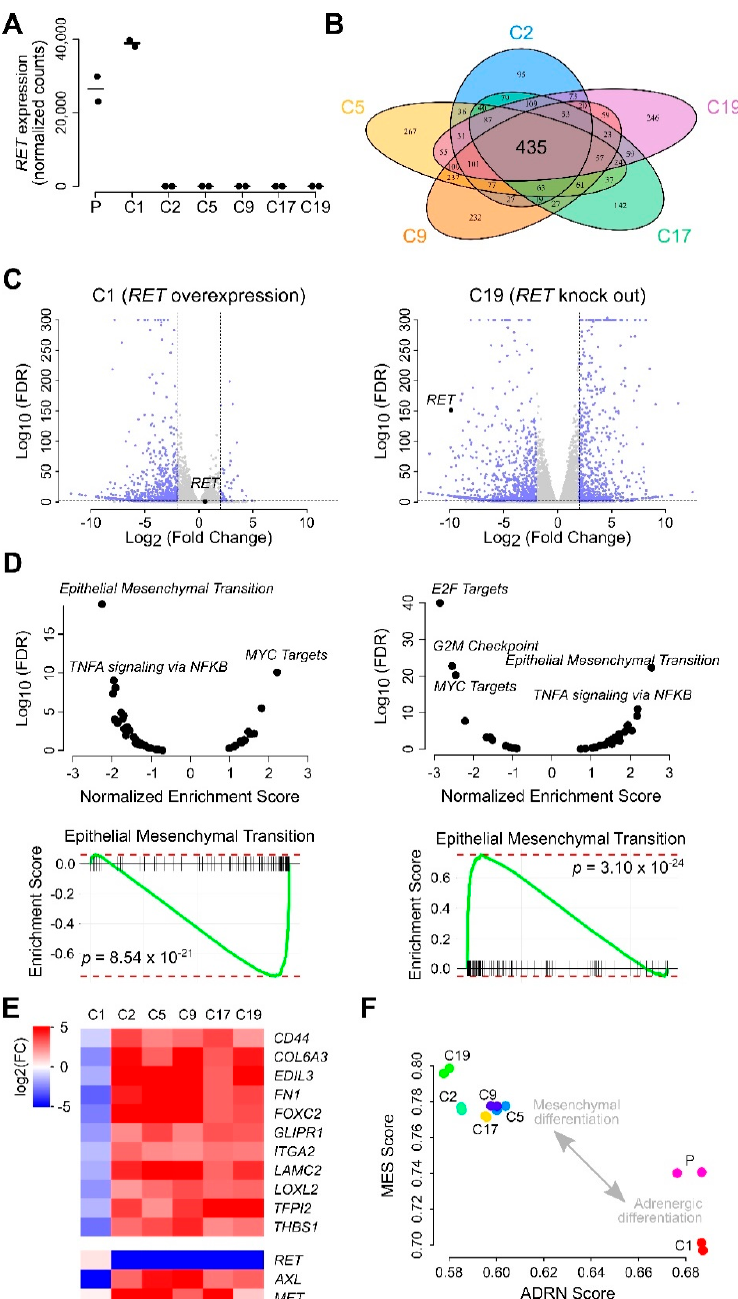
Figure 5. RNA-Seq differential gene expression analysis of RET KO NB cell lines. ( A ) Confirmation of RET KO in different clones. Horizontal lines indicate median values. P stands for parental cells. ( B ) Venn diagram showing the number of differentially expressed (DE) genes for the five RET KO clones as indicated. ( C ) Volcano plots showing DE for clone C1 ( RET overexpression) and C19 ( RET KO). Dashed lines indicate DE thresholds. Up-/downregulated genes indicated in blue. ( D ) Ranked gene set enrichment analysis (GSEA) results for C1 (left plots) and C19 (right plots). Upper panels show normalized enrichment scores and corresponding false discovery rate (FDR) values with labelling of most enriched gene sets. Lower panels represent running score plots for epithelial to mesenchymal transition. ( E ) Heatmap showing log2FC DE values for 11 EMT genes that were upregulated in all RET KO clones (top) and for RET , AXL and MET (bottom). ( F ) Mesenchymal (MES) and adrenergic (ADRN) signature scores for the different clones. All experiments were performed using two biological replicates in each condition. See Table S1 for detailed